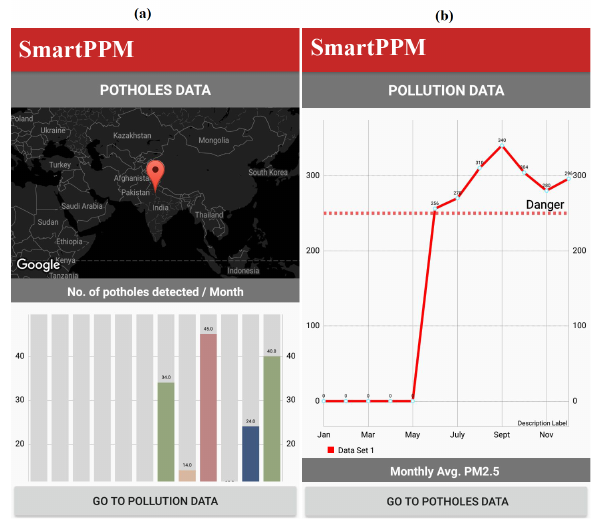
Figure 6. (a). SmartPPM mobile application screen displaying total pothole data collected during our trial. The number of pothole detected per month is displayed through bar graph as well as through the map, and (b)The graph depicting monthly average PM 2.5 encountered by a particular user.